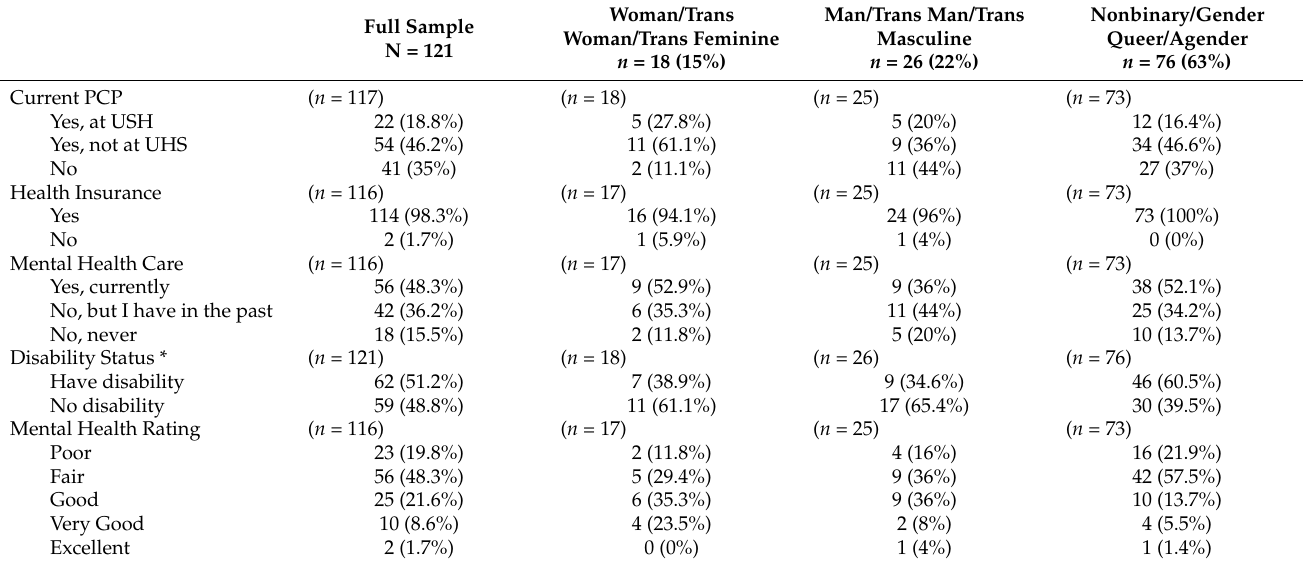
Table 2. Participant Health and Mental Health 1